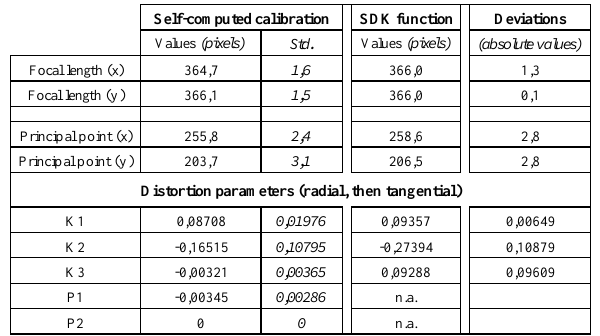
Table 9. Estimated intrinsic parameters using self-calibration, with Microsoft function, and related deviations